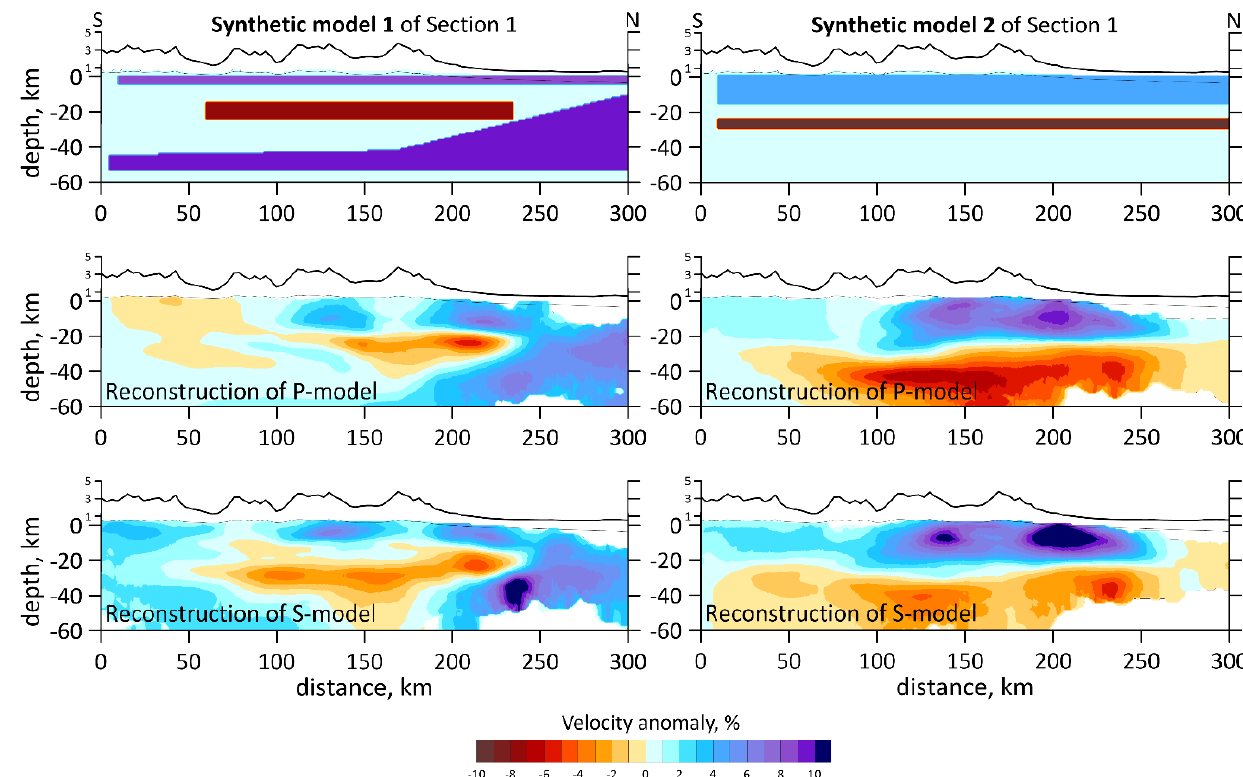
Figure 8. Two synthetic tests with the realistic anomalies set for the vertical Section 1, the same as in Figure 5. Above: parameters of the synthetic models, in the middle and below: reconstruction results for the P- and S-velocity anomalies.